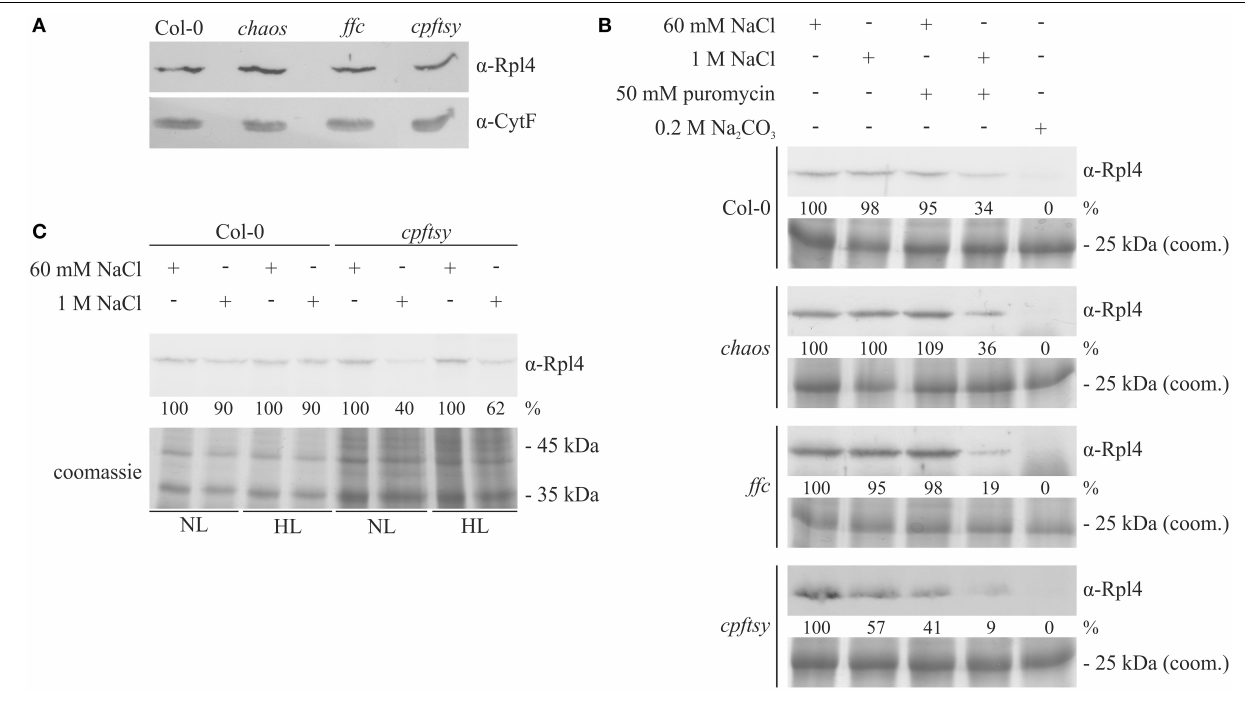
FIGURE 8 | Detection of salt-resistant and thylakoid membrane-associated ribosomes. (A) Thylakoid membranes were isolated from wild type and the cpSRP-mutant plants grown at normal light intensity (120 µ mol photons m − 2 s − 1 ). Subsequently, the thylakoids were treated with 60mM NaCl. Afterwards, a sample corresponding to 15 µ g chlorophyll was subjected to SDS-PAGE with subsequent western blot. The amount of membrane-associated ribosomes was determined using an antibody raised against Rpl4. To control the equal loading, the amount of the luminal protein Cytochrome f was investigated. (B) Thylakoid membranes were isolated from normal light (120 µ mol photons m − 2 s − 1 ) adapted wild type and cpSRP mutants. Subsequently, the thylakoids were divided in 5 equal fractions and treated with washing conditions as indicated above. Afterwards, a sample corresponding to 15 µ g chlorophyll after each washing condition was separated by 12% SDS-PAGE. Finally, the proteins were transferred onto nitrocellulose